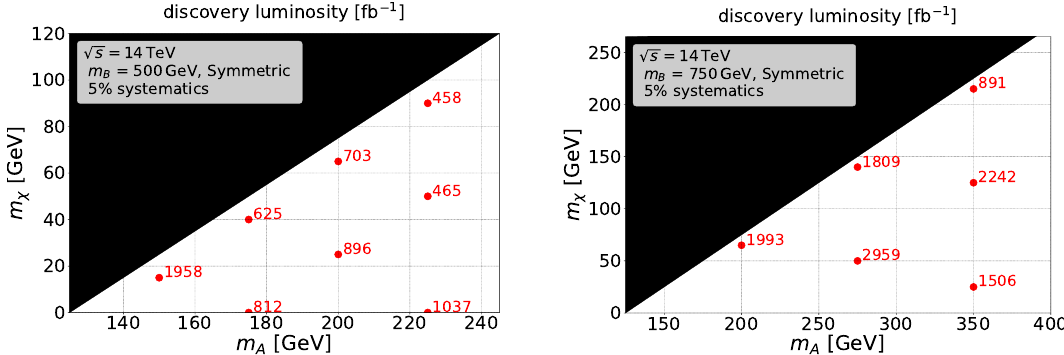
Figure 9 . Luminosity required for a discovery (in fb (cid:0) 1 ) at the HL-LHC in the m A (cid:0) m (cid:31) plane for the symmetric model, with m B = 500 GeV (left panel) and m B = 750 GeV (right panel).